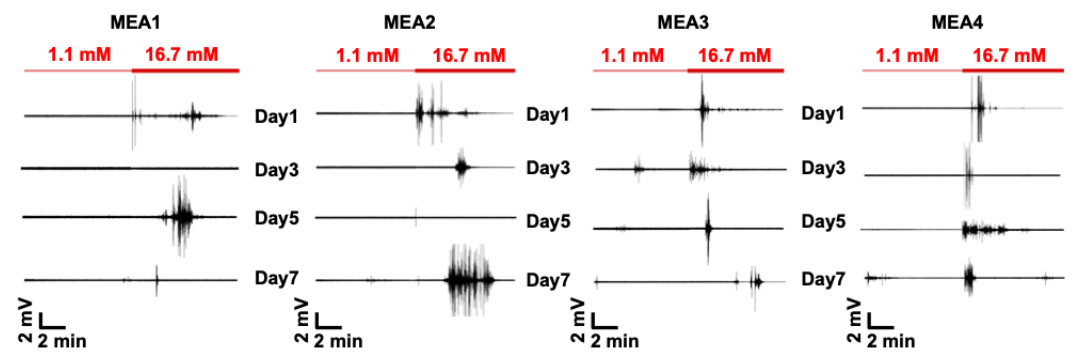
Figure 2. Electrical activity of dissociated human islets. Representative MEA recordings showing electrical activity of islet cells induced by switching from 1.1 to 16.7 mM glucose for different batches of human islets across 7 days.